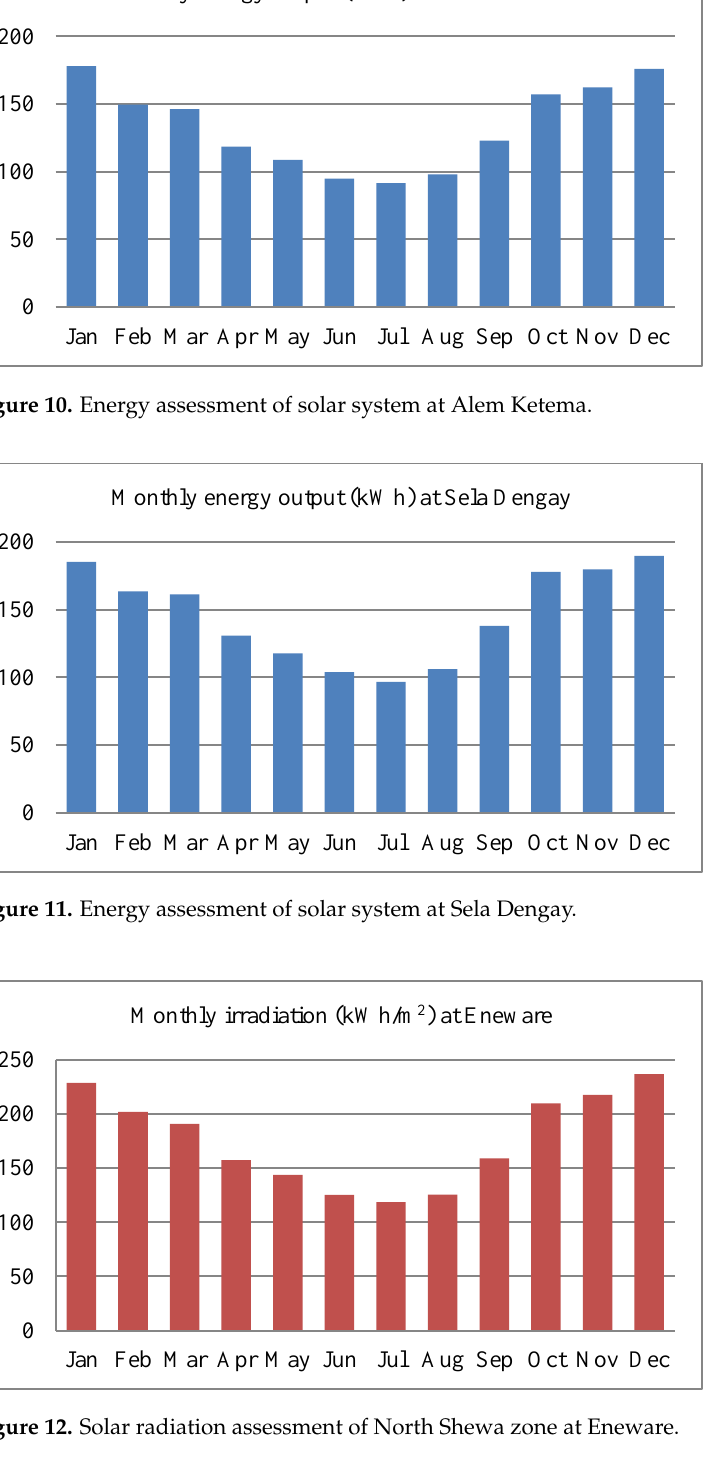
Figure 9. Energy assessment of solar system at Debre Berhan.